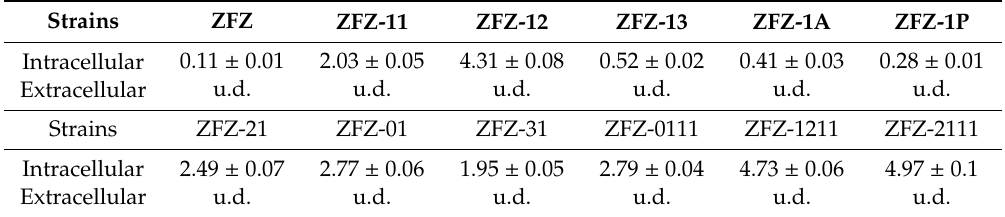
Table 1. The KSDD enzyme activity of di ff erent recombinant